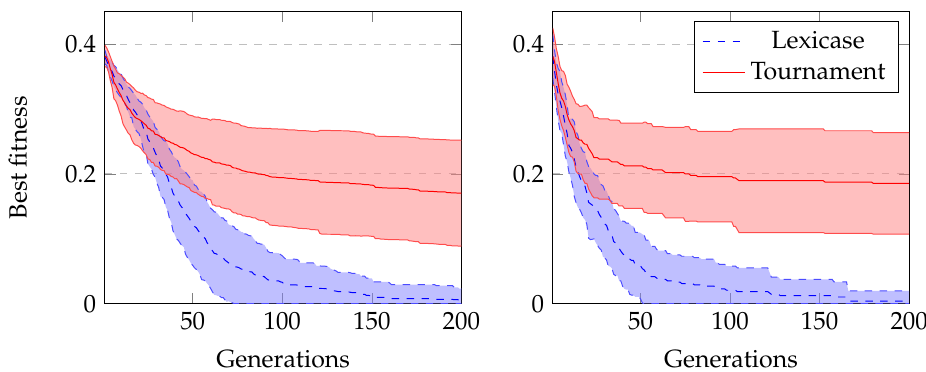
Figure 8. Average fitness of the best individuals across generations using GRAPE with tourna- ment selection or lexicase selection to evolve Boolean problems: 11-bit Multiplexer ( left ) and 4-bit Parity ( right